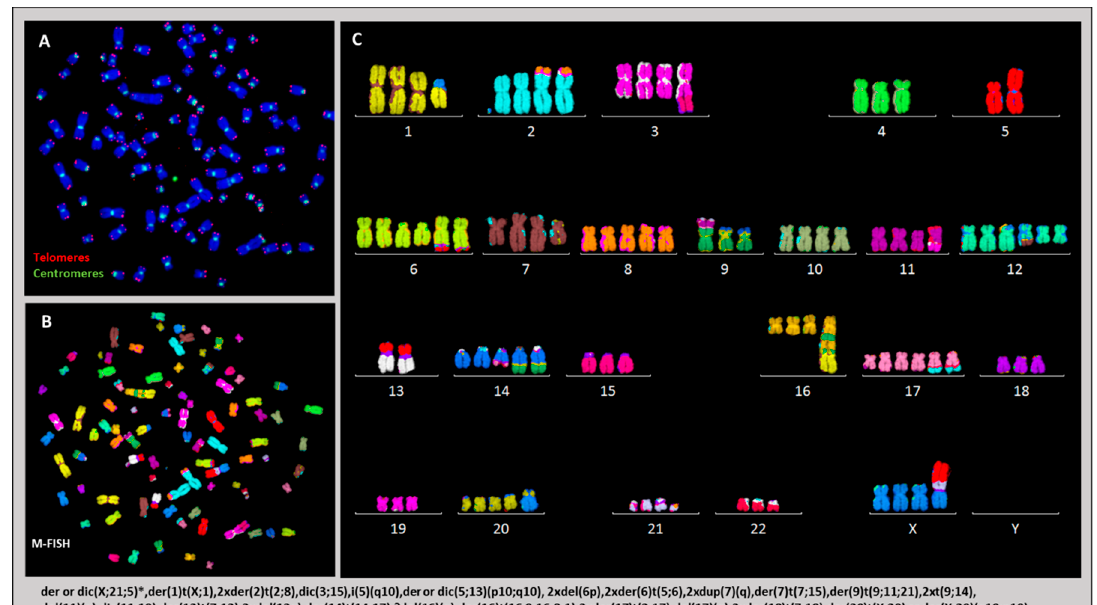
Figure 10. Chromosomal rearrangements in L428 cells. ( A ) Telomere and centromere staining followed by ( B ) M-FISH allows ( C ) detailed classification of chromosomes and identification of all clonal chromosomal aberrations listed at the bottom of the figure. * Only the dic(X;21) is clonal, and the tric(X;21;5) is an additional aberration (63× magnification).